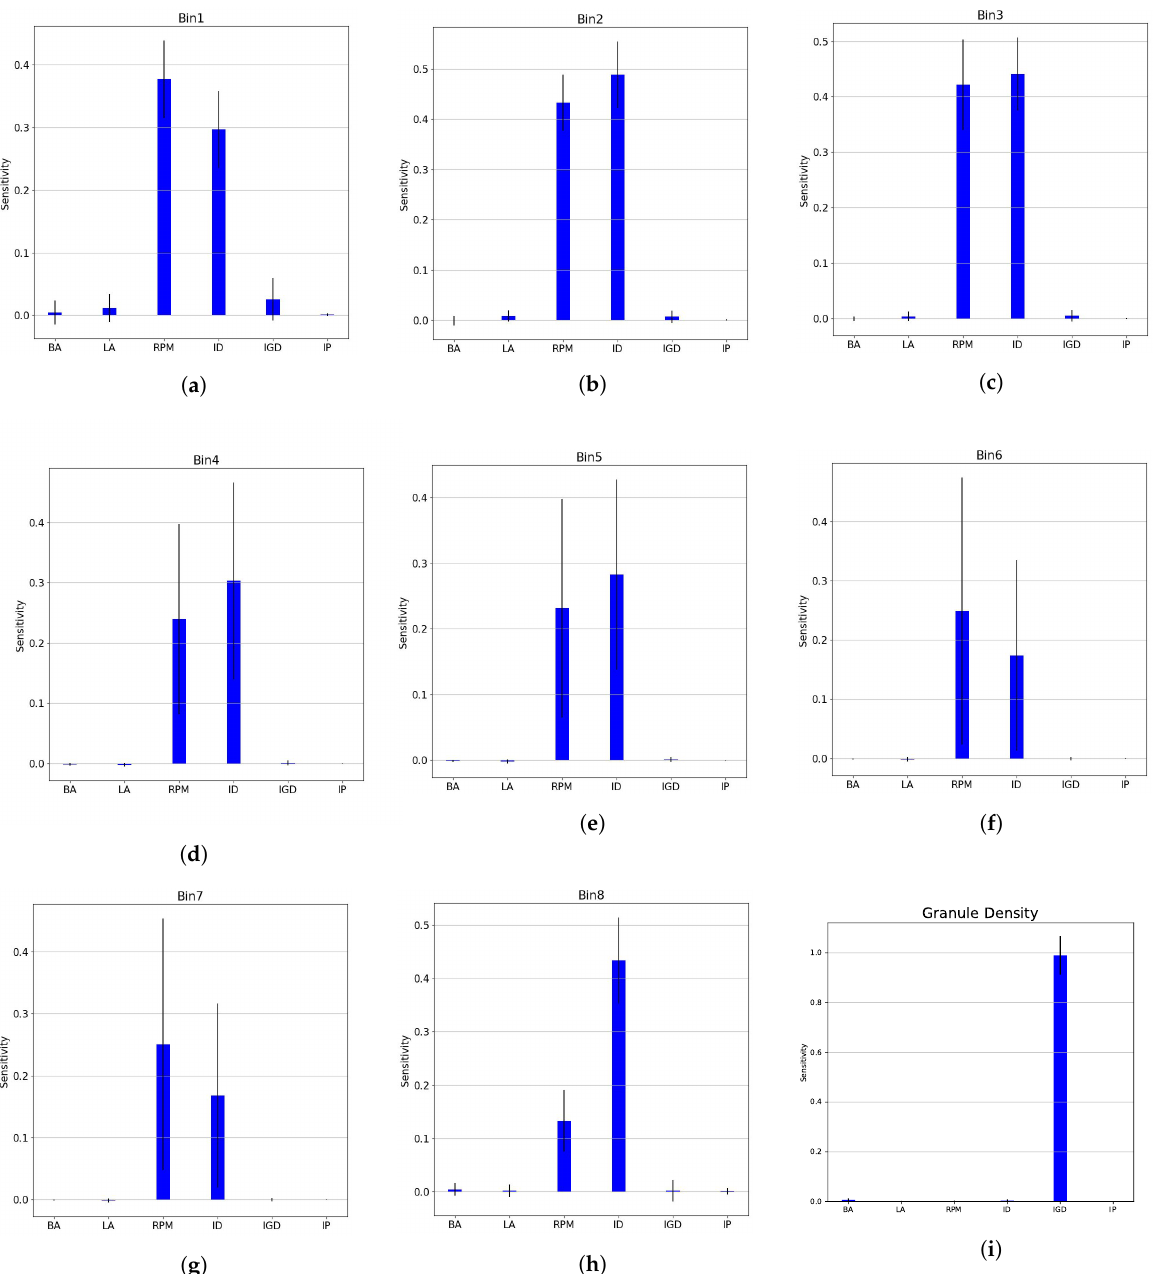
Figure 6. Input parameter sensitivity analysis for the physics-constrained neural network. Sub-figures ( a – h ) represent the effect of the input parameters on the various sieve cuts chosen. The interchangeable effect of RPM and impeller diameter has been identified by the PCNN. Sub-figure ( i ) indicates that the effect of initial particle size affects the granule density the